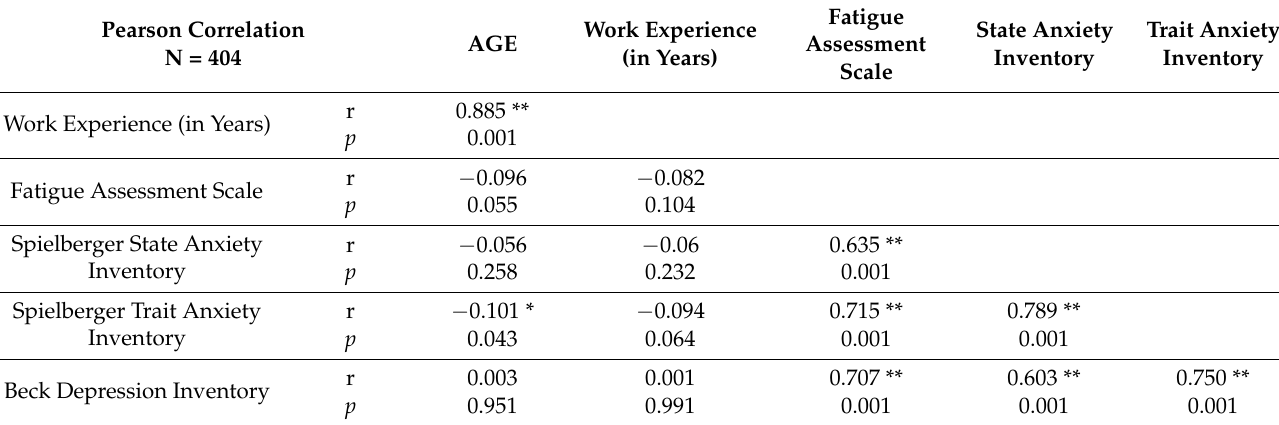
Table 2. Correlations among age, work experience (in years), fatigue, anxiety and depression.